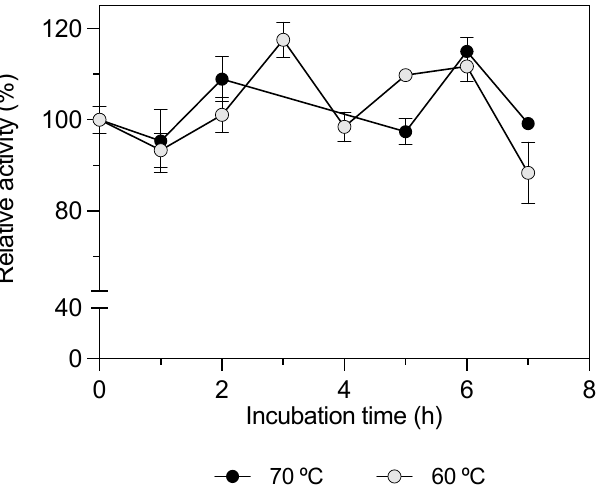
Figure 2. KLEST-3S thermal stability. Thermal stability profile at 60 °C (— —) and 70 °C (—•—). The enzyme solution was incubated at different times between 0 and 7 h in a water bath. The pNP C12 substrate was assayed under the standard assay conditions, and residual activity was calcu- lated; 100% KLEST-3S specific activity was 10.27 ± 0.30 U/mg.